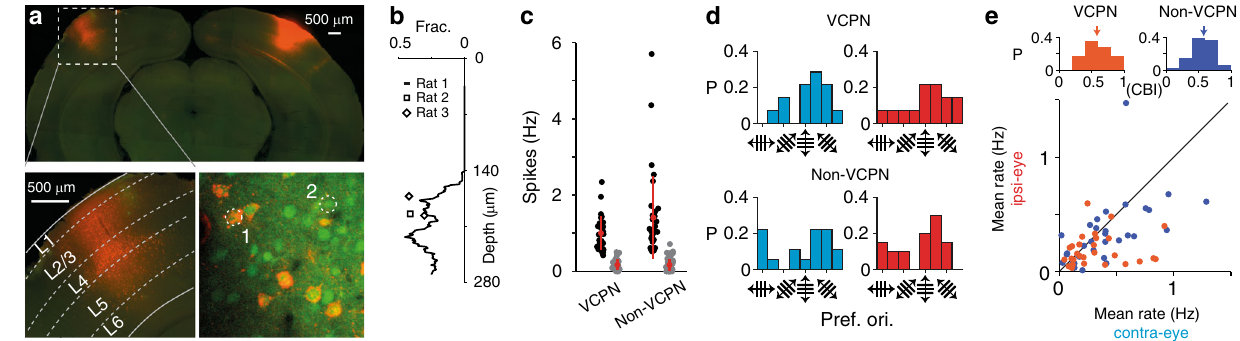
Fig. 2 Functional responses of projecting and non-projecting neurons are indistinguishable. a Coronal rat brain section showing the CTB-Alexa 594 injection site and retrogradely labeled neurons in contralateral V1 (upper) expanded view of retrogradely labeled projection neurons location across cortical layers (lower left, from upper image). Lower right: Overview of neurons labeled with OGB-1 (green, e.g. neuron 2) with callosal projecting neurons (VCPNs) co-labeled with CTB (red, e.g. neuron 1). b Fraction of VCPNs as a function of depth from the pia ( N = 3 animals). c Pooled data of spontaneous (gray) and maximum stimulus response (black, average max. response to preferred orientation for VCPNs ( N = 28 neurons) and non-VCPNs ( N = 33 neurons)) and mean ± SD (red) for each group. d Distribution of preferred orientations for orientation selective neurons from both VCPN and non-VCPN groups (ipsi-eye stimulation, red, contra, turquoise). e Scatter plot comparing mean stimulus response of ipsi- to the mean response from the contralateral eye stimulation (lower) for VCPNs (orange markers) and non-VCPNs (blue markers) with the distribution of the contralateral bias index shown in upper panels (see “ Methods ” section for